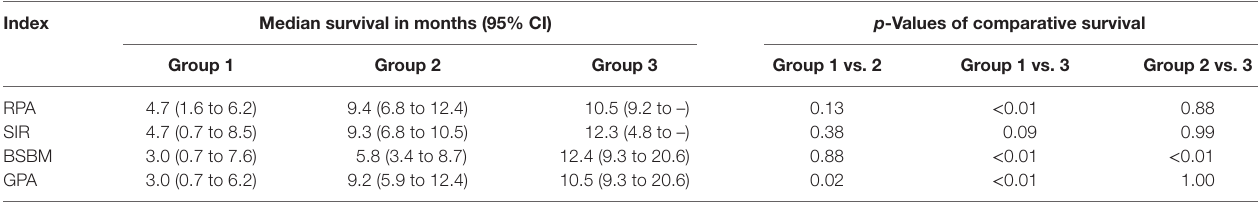
TaBle 2 | survival and comparison between groups based on each prognostic index.